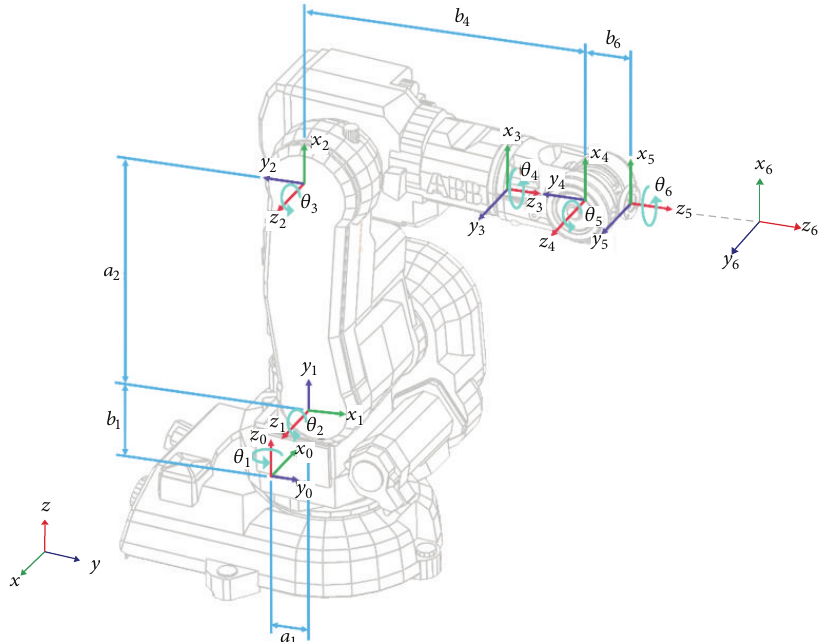
Figure 1: Architecture of the industrial robot ABB IRB 140.